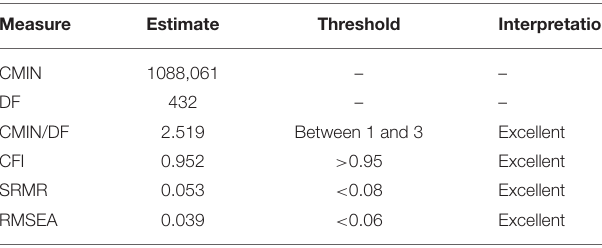
TABLE 1 | Model fit measures.